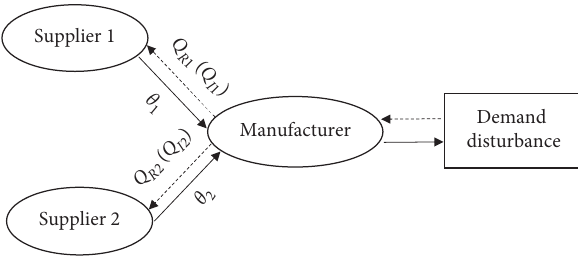
Figure 1: Conceptual model of dual-source